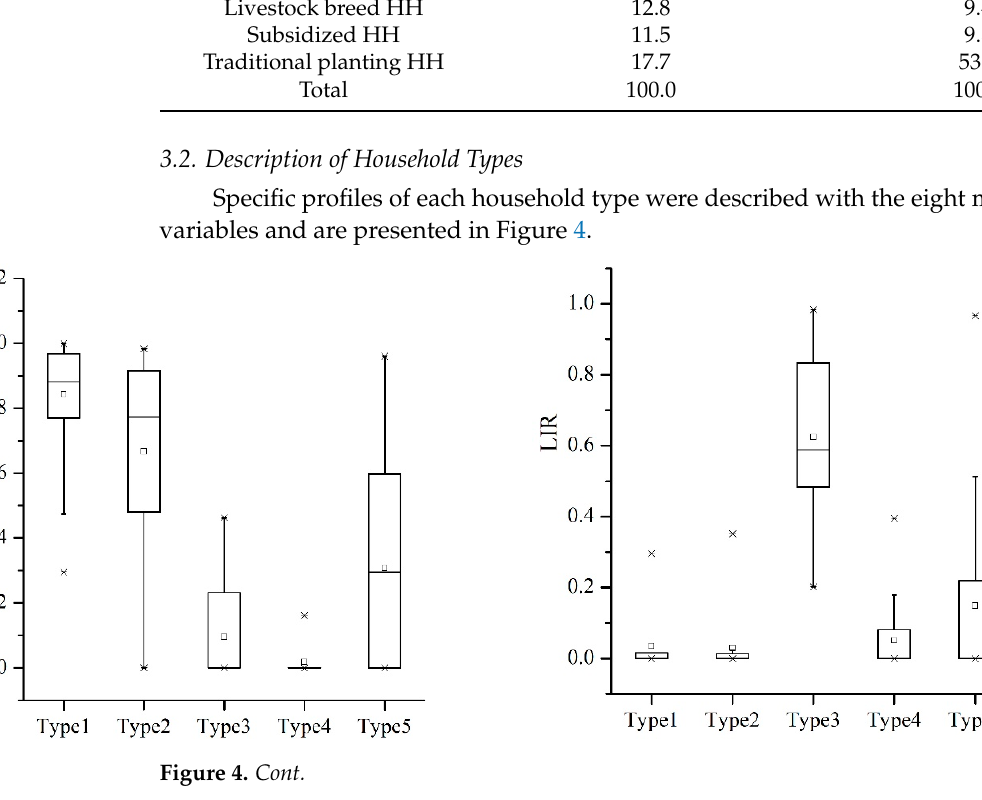
Household Typology